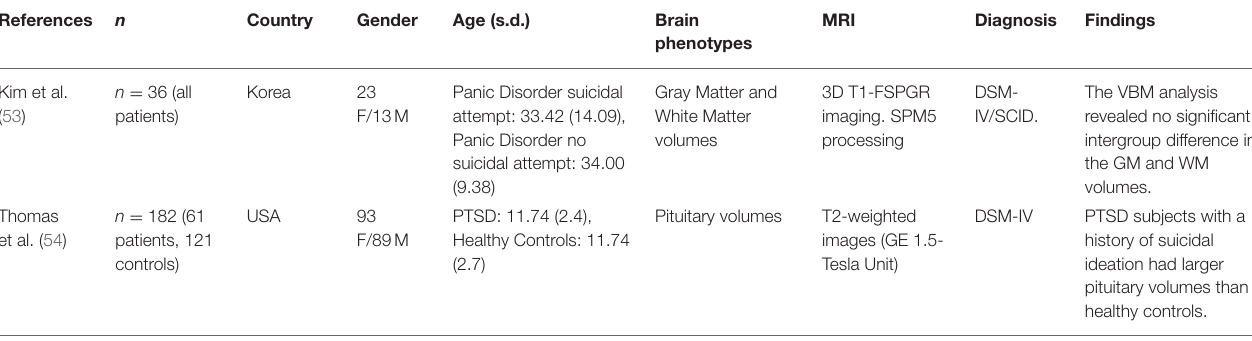
TABLE 6 | Main characteristics of articles regarding other affective disorders and